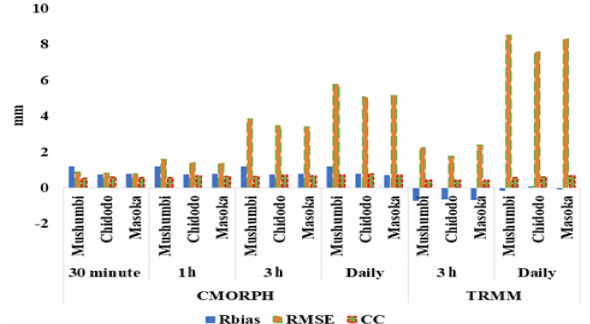
Figure 2. Standard statistic error for both SREs at different timesteps.